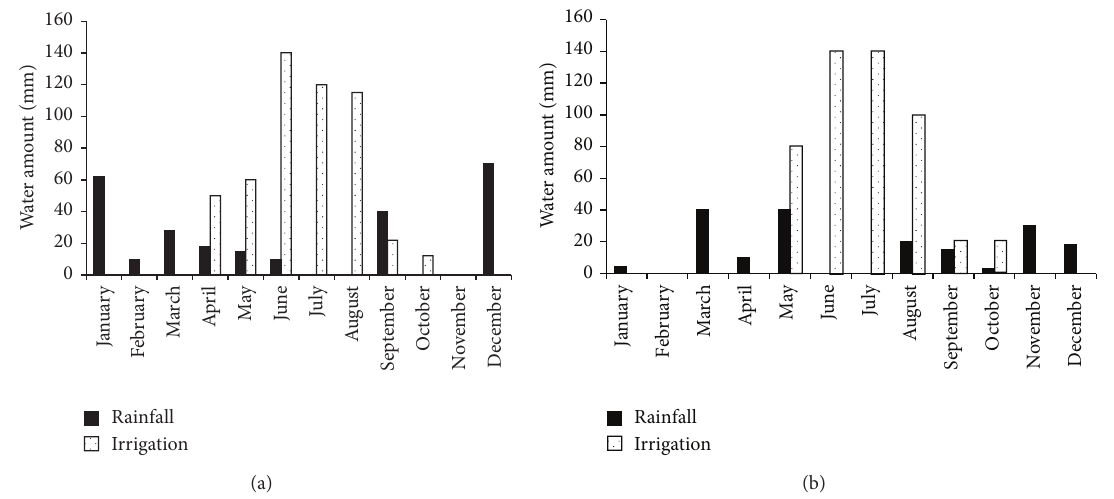
Figure 2: Monthly rainfall and irrigation values (mm) registered at the experimental site in 2003 (a) and 2004 (b).